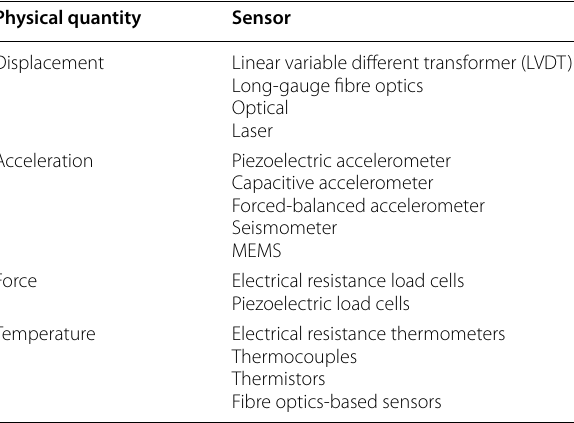
Table 2 Sensor type based on physical